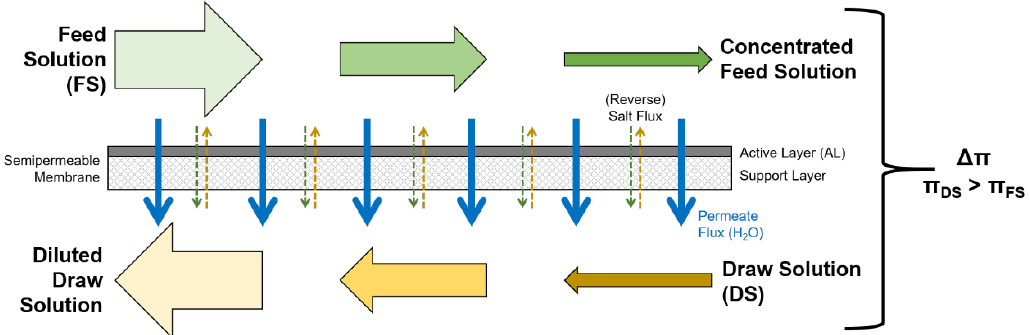
Figure 1. Forward osmosis (FO) process with membrane active layer facing towards the feed solution (FS) (active layer feed solution (ALFS) or FO-mode) [6].